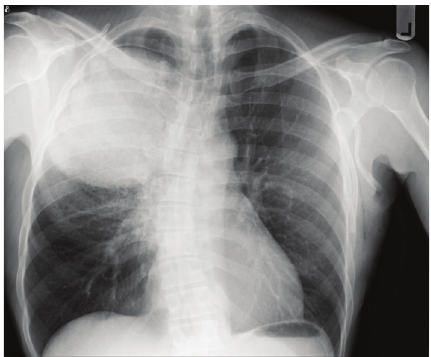
Figure 3: Chest X-ray: Rt upper lobe mass.